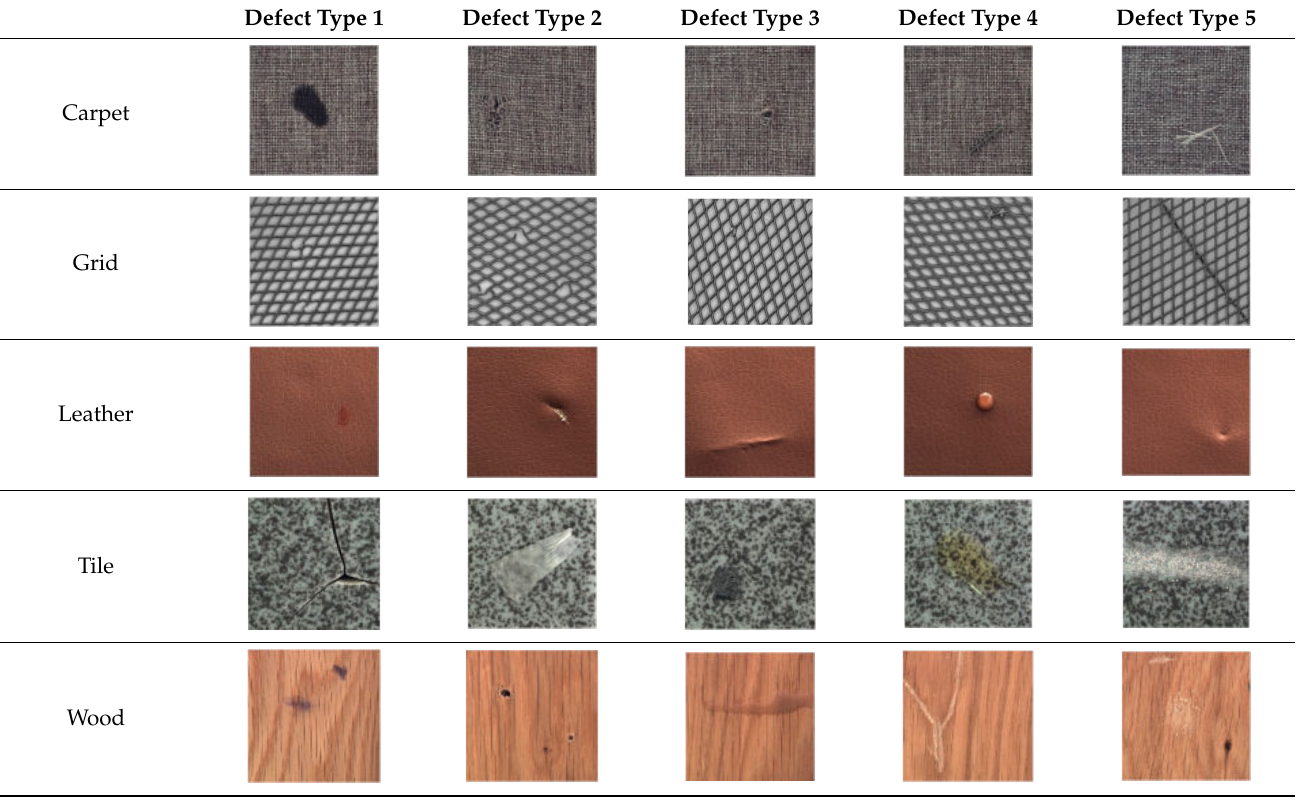
Table 4. Typology of defects present in the different